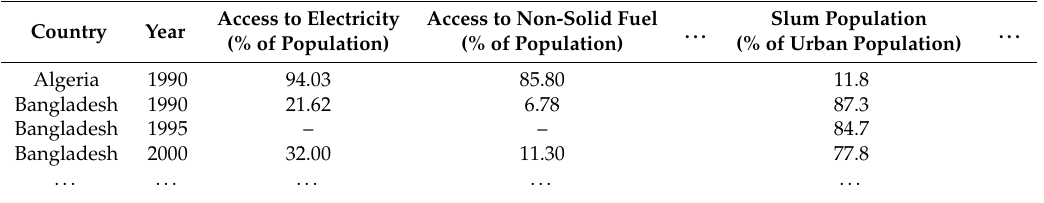
Table 2. Excerpt of the used data set